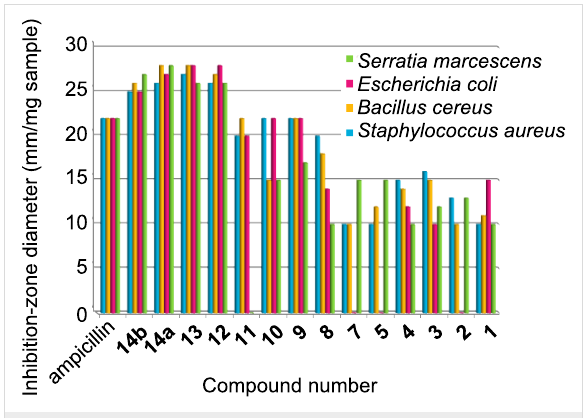
Figure 1: Graphical representation of the antibacterial activity of tested compounds compared to ampicillin.